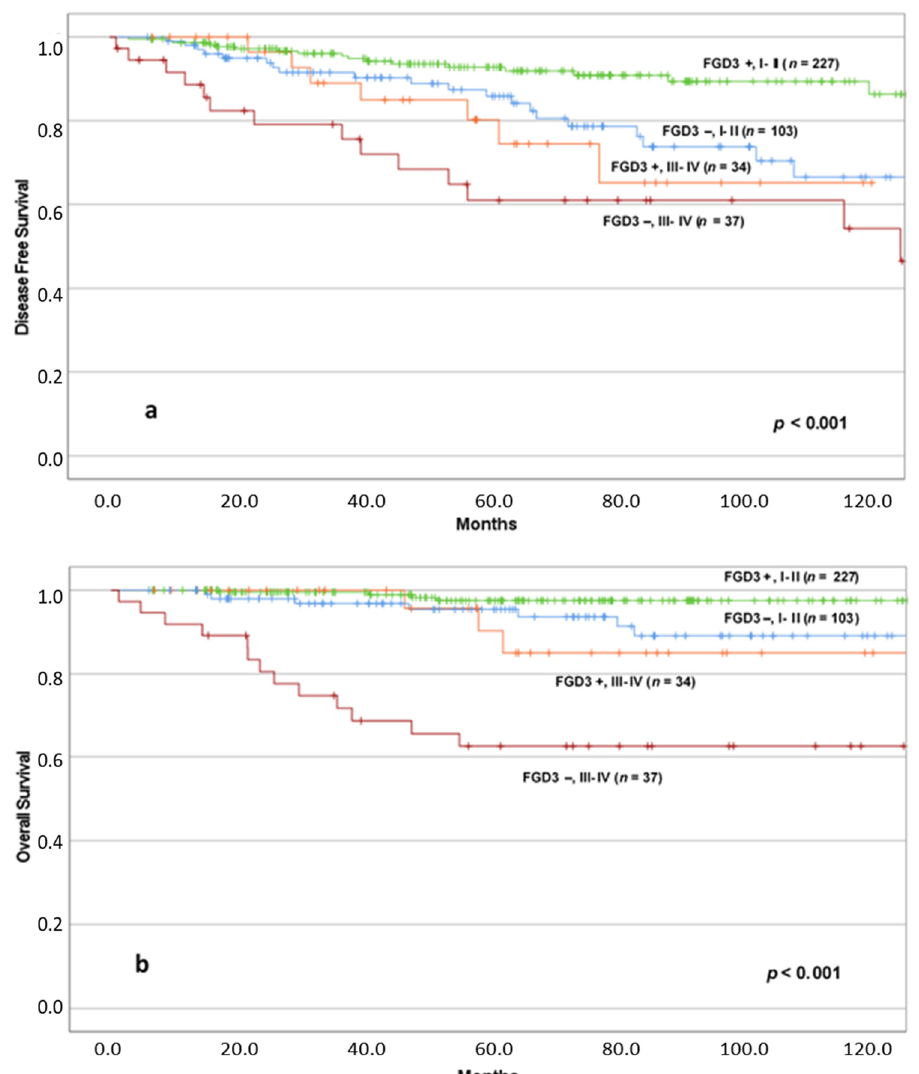
Figure 4. DFS ( a ) and OS ( b ) according to FGD3 expression in AJCC stage stratified groups. Abbreviations: FGD3+: high FGD3 expression; FGD3 − : low FGD3 expression; I–II: I, II AJCC Stages; III, IV: III, IV AJCC Stages. Notes: ( a ) FGD3 − , I II vs. FGD3+, III IV ( p = 0.551); ( b ) FGD3 − , I II vs.